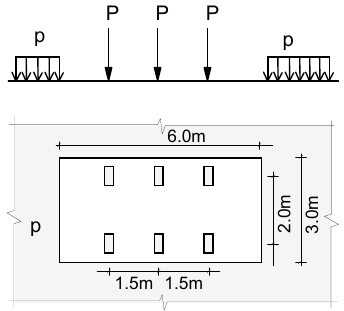
Figure 1. Current Brazilian load model: plan view and cross section.